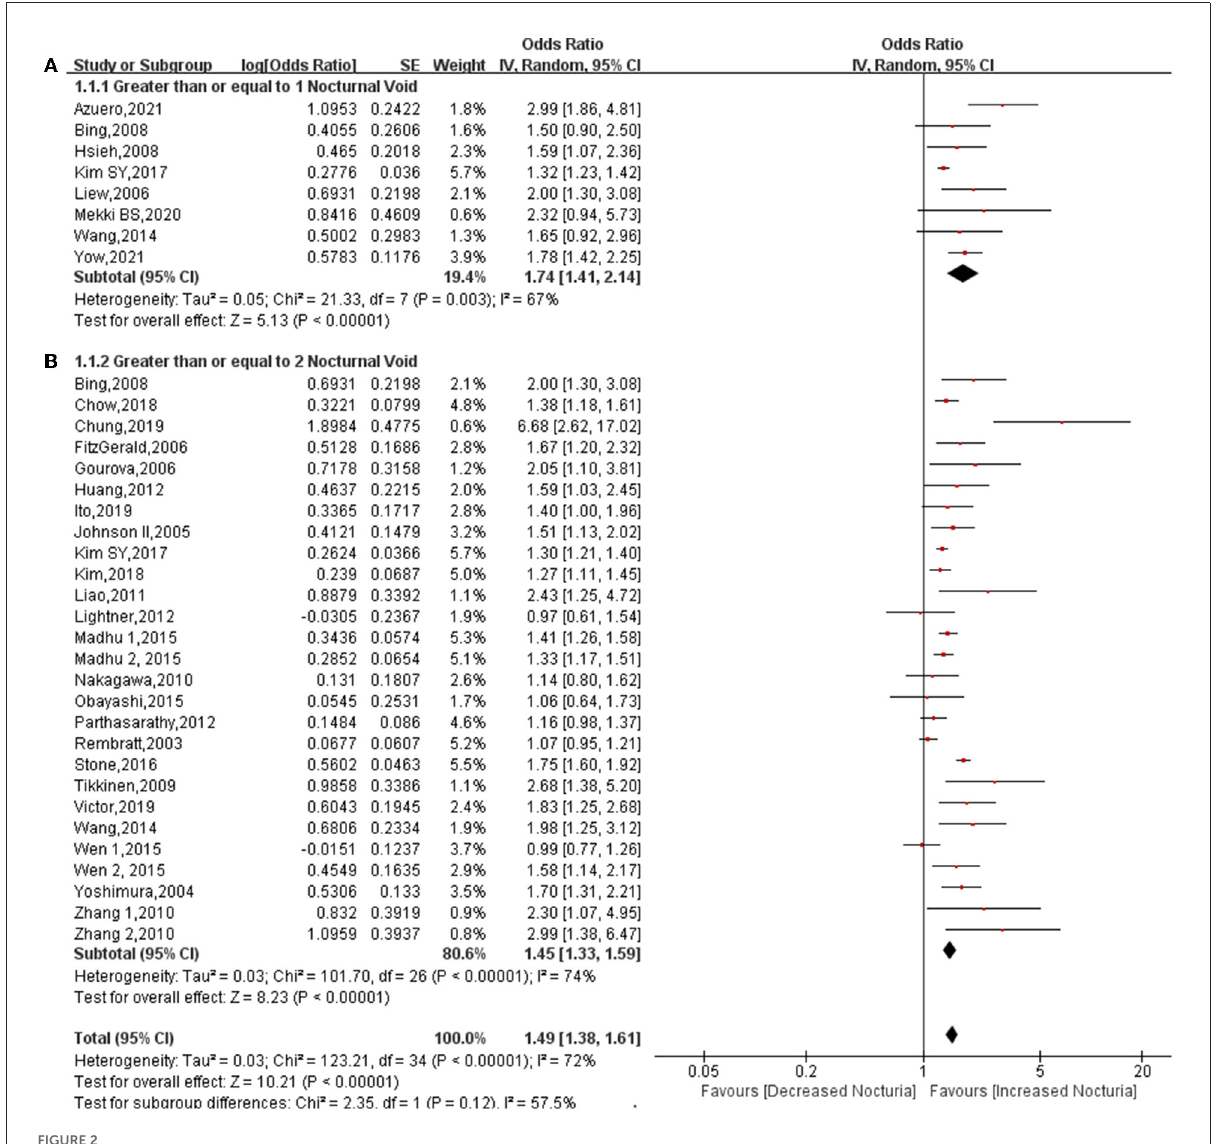
FIGURE2 Forest plot for the association between diabetes and nocturia stratified by number of nocturia. Nocturia ≥ 1 void (A) , nocturia ≥ 2 void (B) .